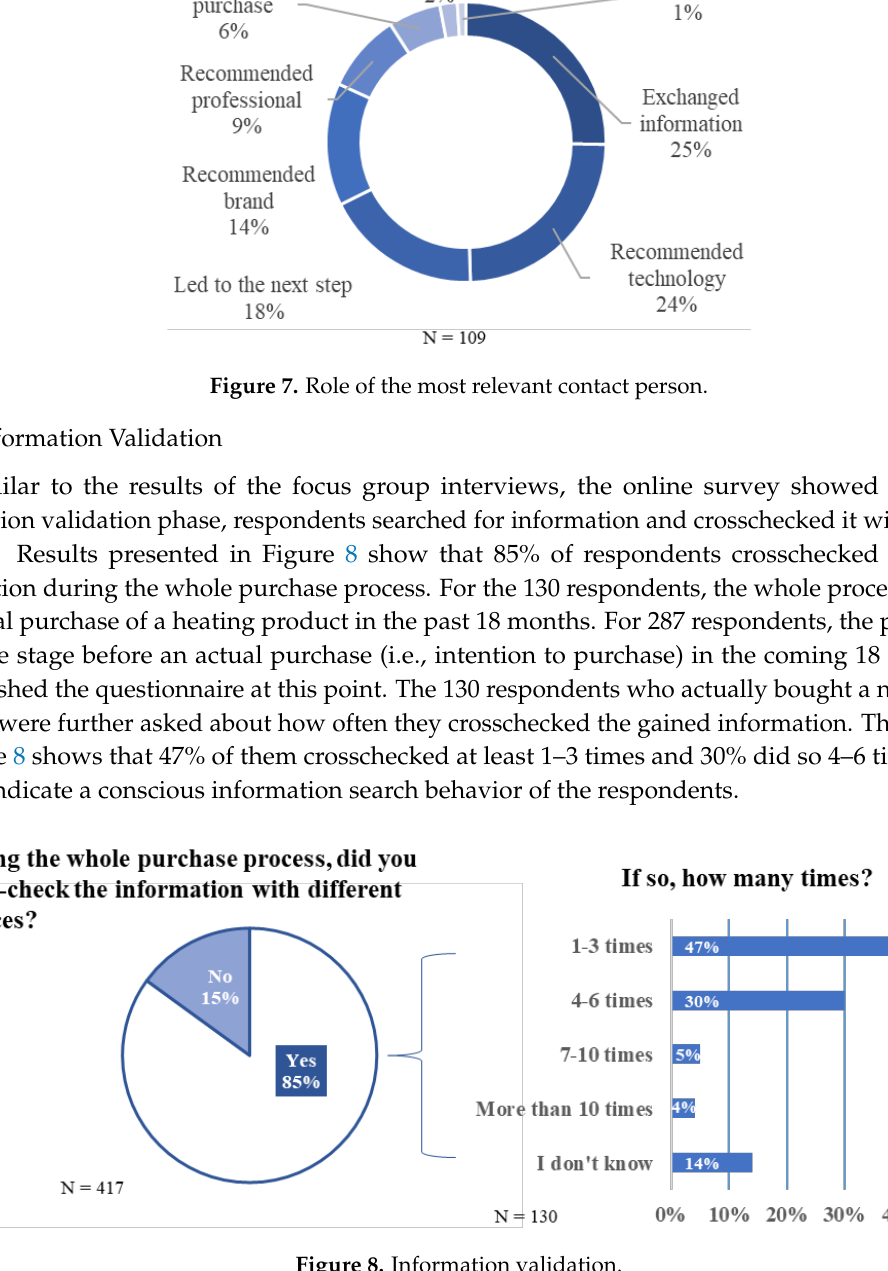
Figure 9. Sources of information at the stage of validation. 5.2.5. Final Decision Respondents ( N = 130) were asked to choose the three most influential sources from those mentioned in Figure 9 that led them to the final decision. As presented in Figure 10, 44% of the respondents quoted online sources versus offline source (13%). Influencing information sources from the social environment were quoted by 30% of the respondents versus the installer (14%).